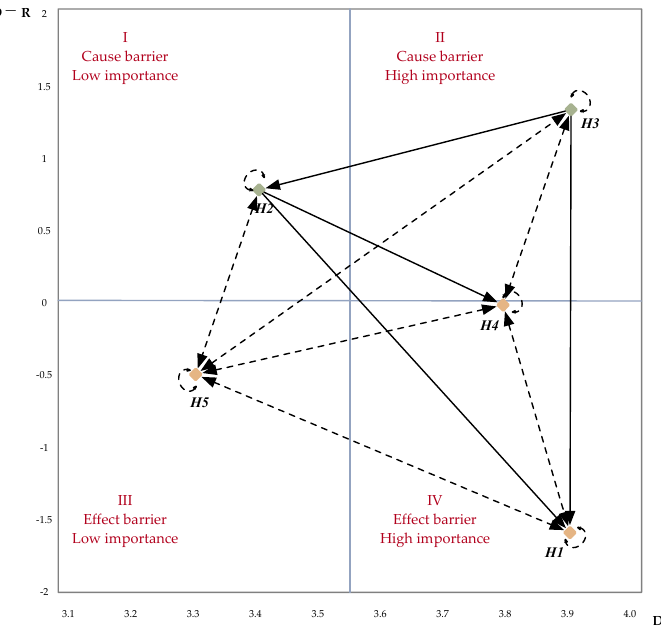
Figure 3. The interactions between five first-level indicators (Solid lines represent a one-way impact, dashed lines represent a two-way impact).